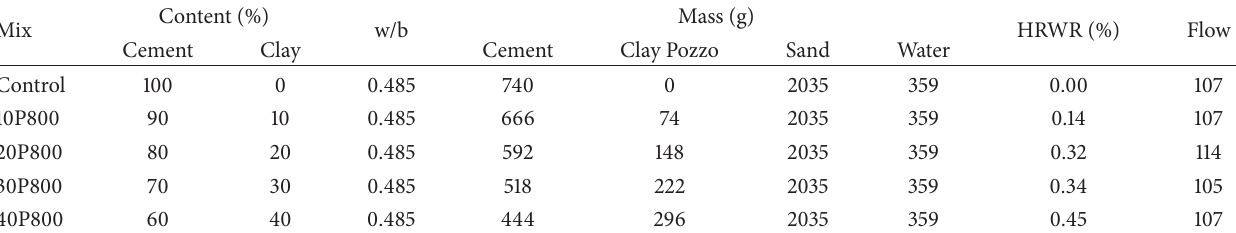
Table 2: Mortar mixture proportions of cement and calcined clay at 800 ∘ C.